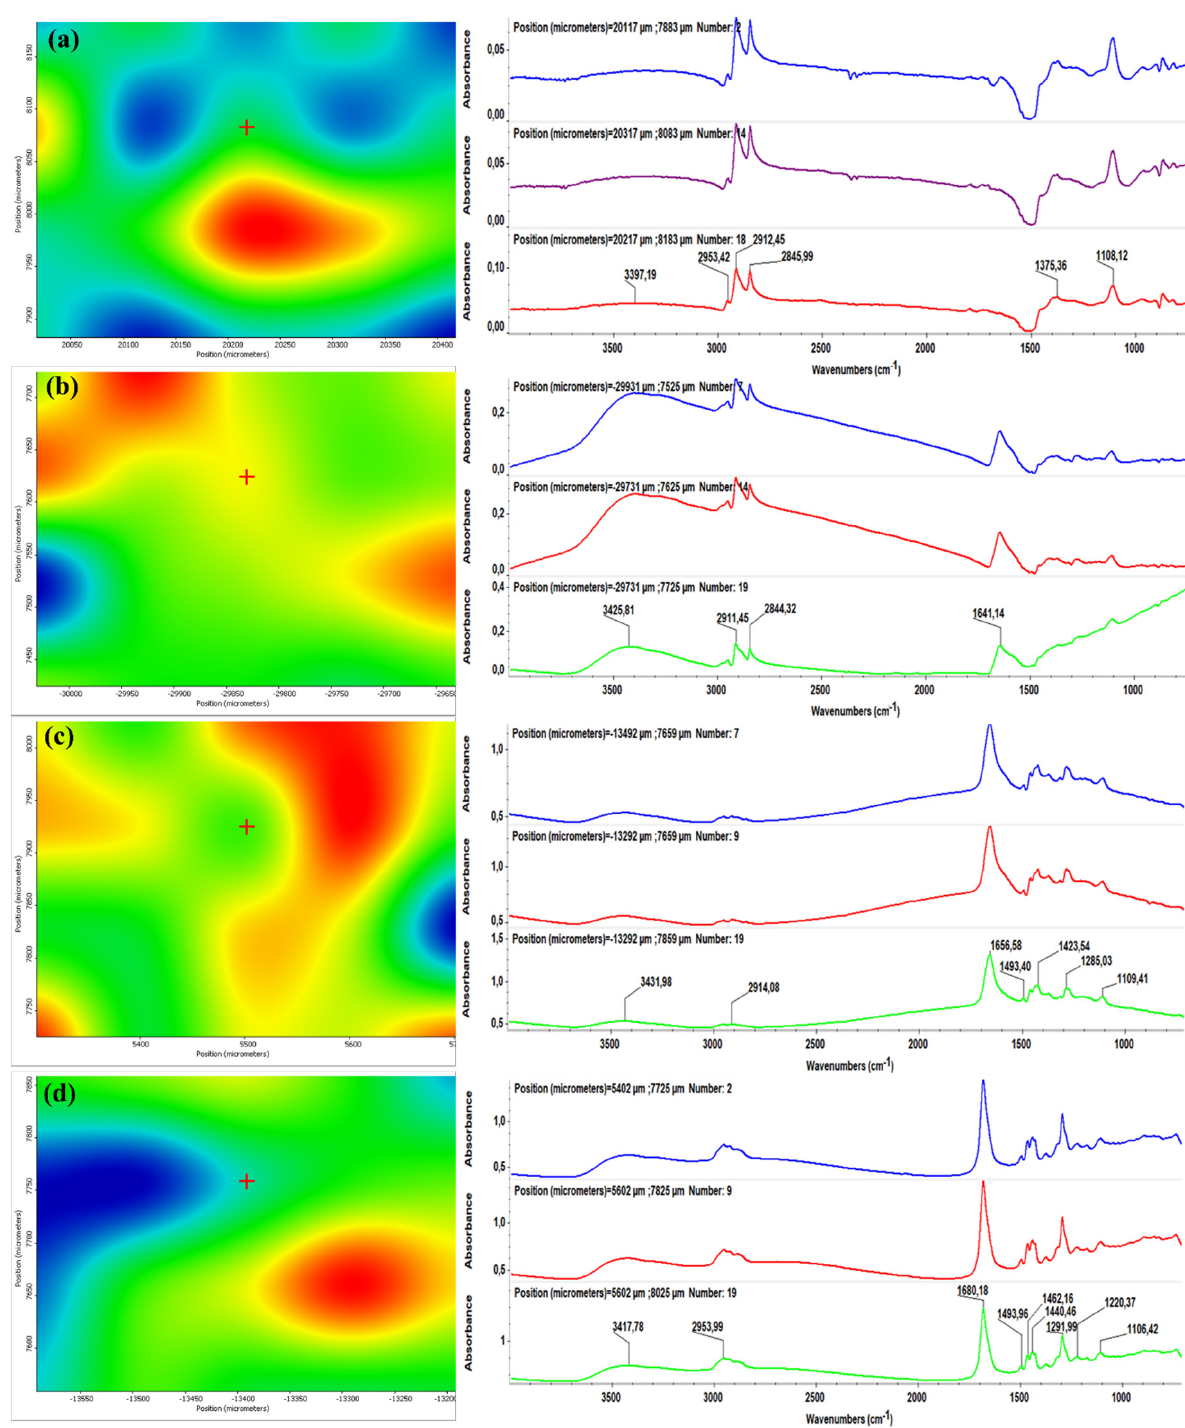
Figure 4. Second derivate IR mappings (left) and FT-IR spectra (right) of CEFTRI/PVP/FW ( a ) drop-cast, and thin films deposited at a laser fluence of ( b ) 100 mJ/cm 2 , ( c ) 200 mJ/cm 2 , and ( d ) 300 mJ/cm 2 . The color modification of the IR maps from Figures 3 and 4 (left images) is correlated to the variation of absorbance from blue to red (these colors correspond to extreme lowest and highest absorbance intensities, respectively). It can be generally noticed that the infrared micrographs of all of the drop-cast samples (Figures 3a and 4a) have an abundance of blue areas that indicate the reduced amount of material onto the substrates. In the case of MAPLE-deposited samples (Figures 3b–d and 4b–d), the blue areas are more